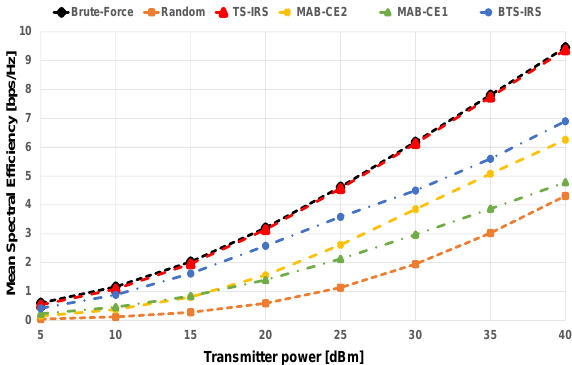
Figure 3. Mean spectral efficiency versus transmitter power [35].